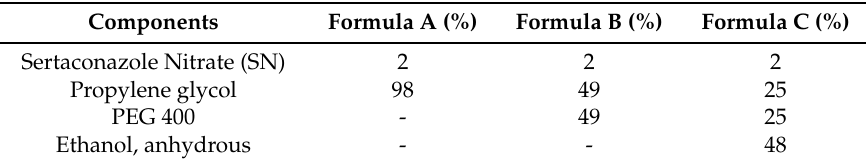
Table 1. Composition of SN (2% w / w ) in different vehicles.